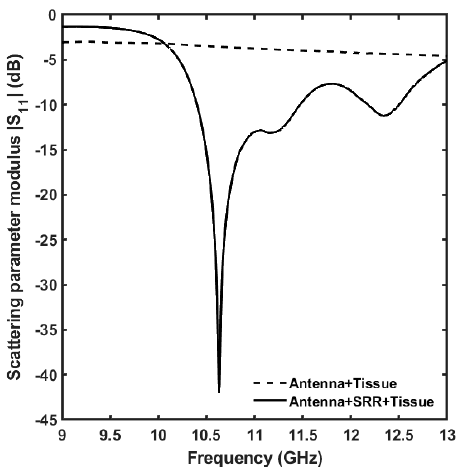
Figure 11. Measured scattering parameter modulus | S 11 | versus frequency of SIW cavity-backed patch antenna with (continuous line) and without (dashed line) the metamaterial superstrate that irradiates in the biological tissue.